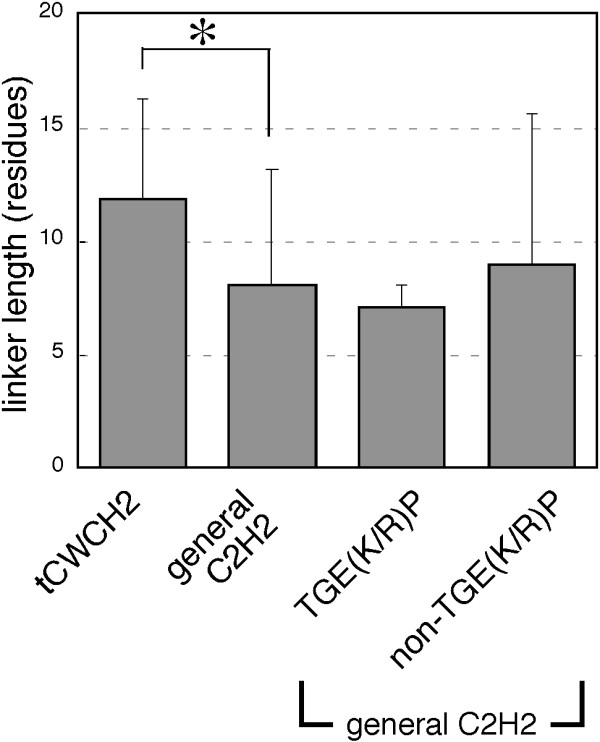
Comparison of linker length between the tCWCH2 sequence motif and general C2H2 ZF. The bars indicate the mean lengths of the linker sequence between C2H2 motifs in the indicated groups. We defined the linker length as the number of amino acids between the last histidine of a ZF and the first cysteine of the C-terminally flanking ZF. The PDOC00028 (general C2H2) alignment contained 12326 sequences and we found 10025 linkers in it. The general C2H2 sequences was further divided into two groups based on the presence or absence of "TGE(K/R)P". The sequence numbers of each group: tCWCH2, 614; general C2H2, 10025; "TGE(K/P)", 4640; "non-TGE(K/R)P", 5385). Error bar, standard deviation. *, P < 1 × 10-100 in Mann-Whitney U-test.